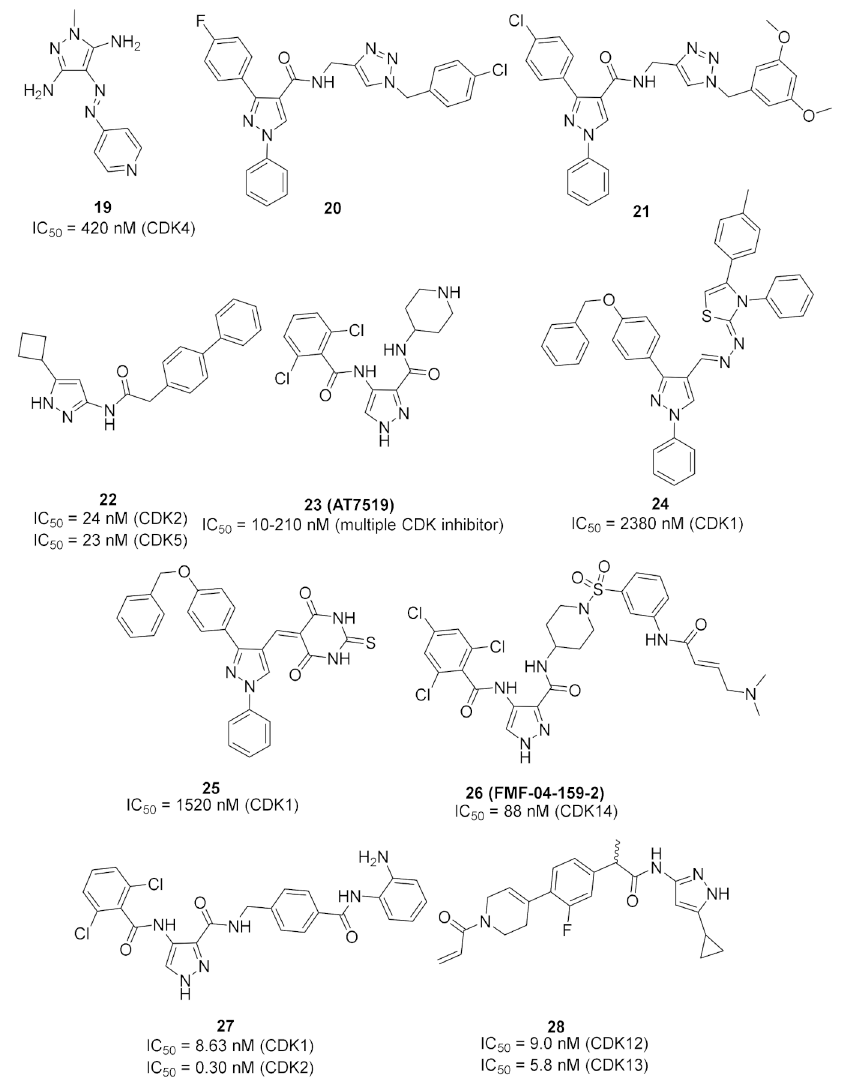
Figure 26. Structures of pyrazole-based CDK inhibitors and their IC 50 values.